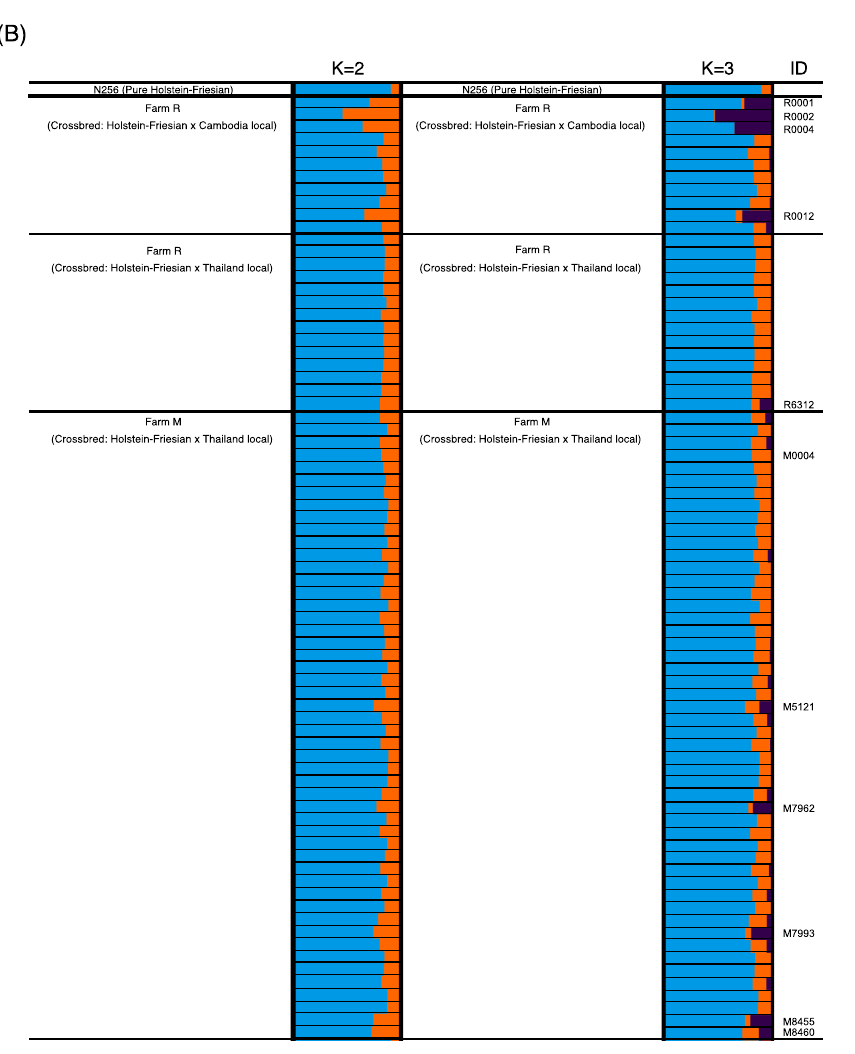
Figure 2. Delta K values at K = 2 to K = 4, generated by STRUCTURE HARVESTER. ( A ) STRUCTURE plots for the probability of assignment to two (K = 2) and three (K = 3) genetic clusters, for the pure Japanese Holstein-Friesian breed, and 75 Cambodian dairy cattle, from two different farms ( B ). Each horizontal bar indicates an individual, and each color indicates the probability of assignment to one of the genetic clusters.